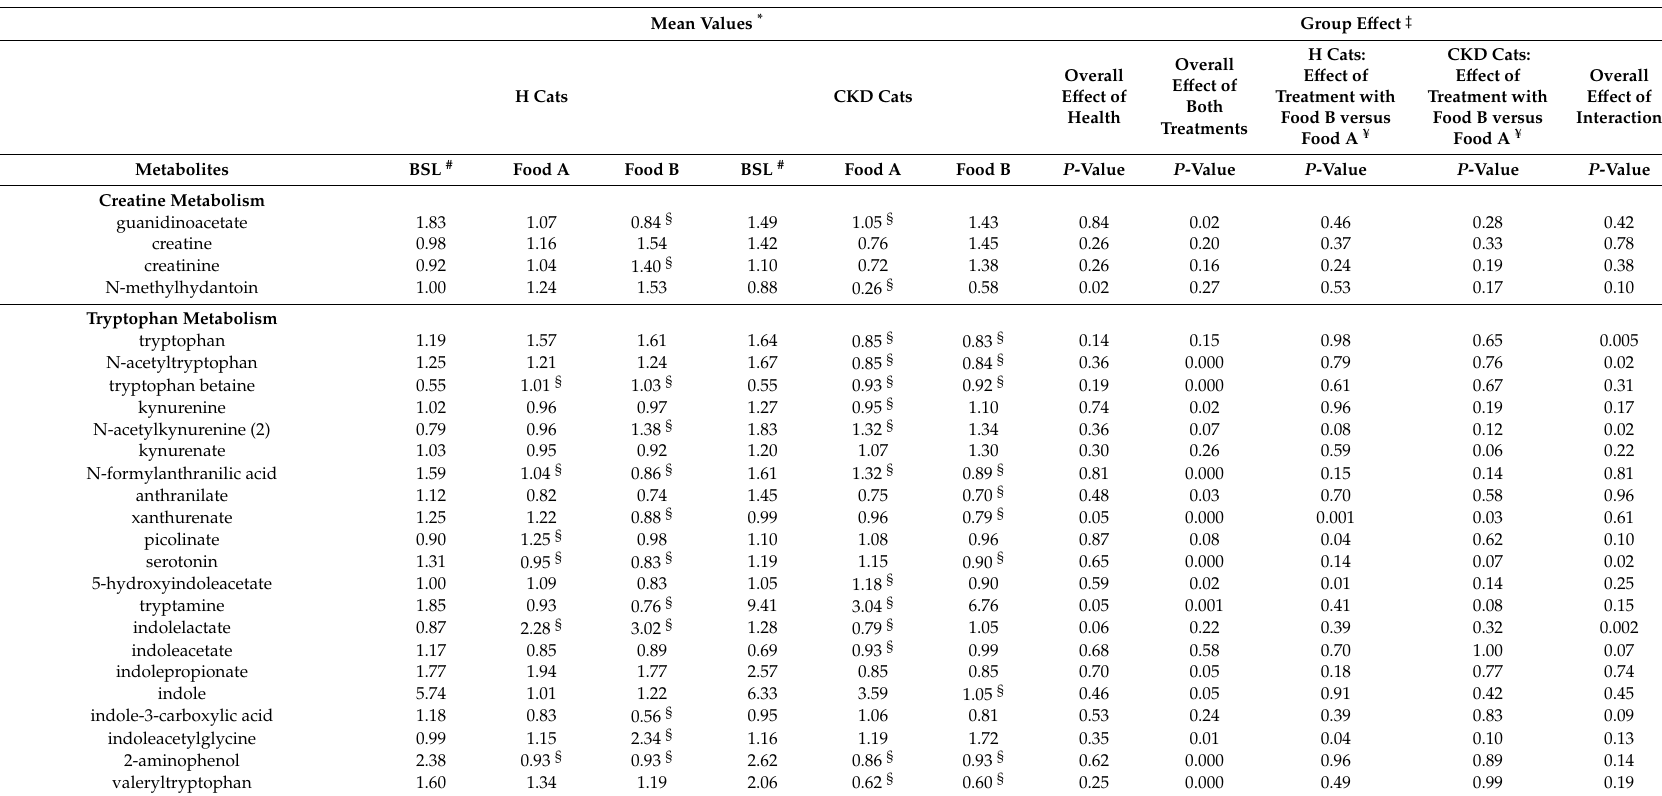
Table 2. Relative fecal metabolite concentrations for other renal-associated markers and metabolites in healthy cats (H cats) and CKD cats at baseline (after feeding pretrial food 1 for 14 days) and after feeding food A 2 (containing scFOS) or food B 3 (containing apple pomace) as fiber sources for 4 weeks